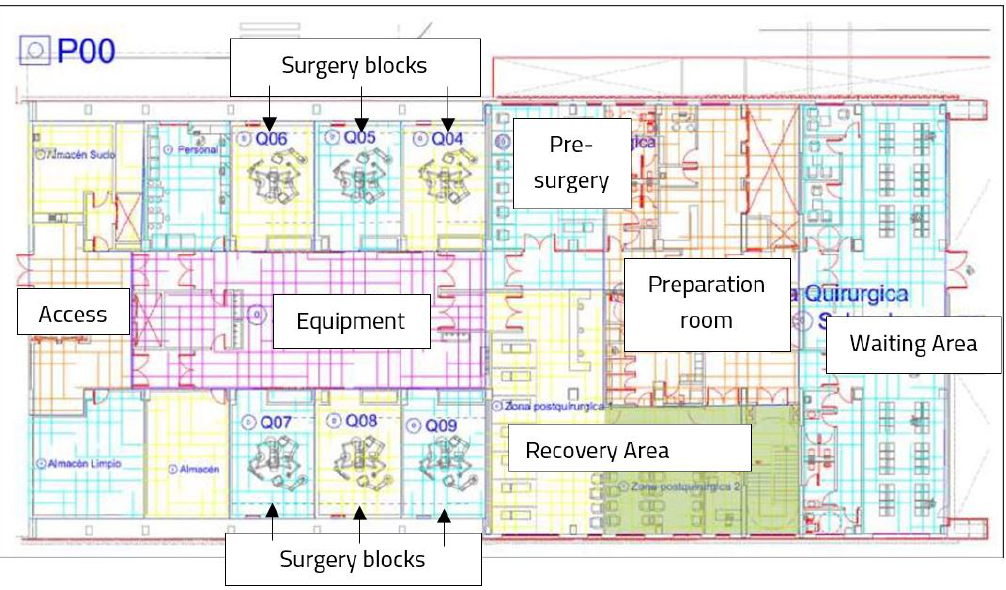
Figure 1. Composition of the operating room